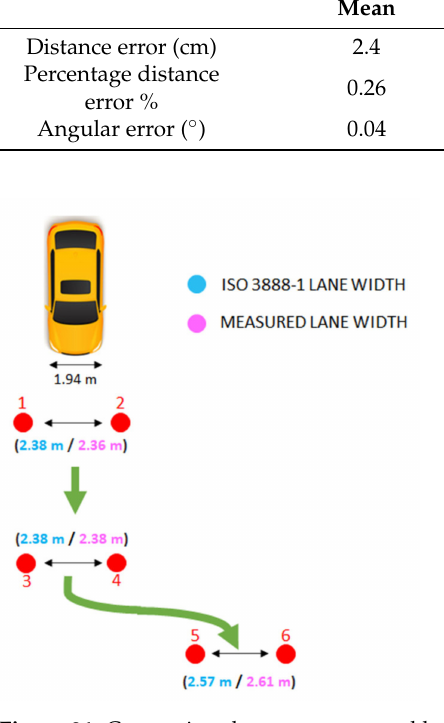
Figure 21. Comparison between measured lane widths (purple) and those defined by the ISO 3888-1 standard